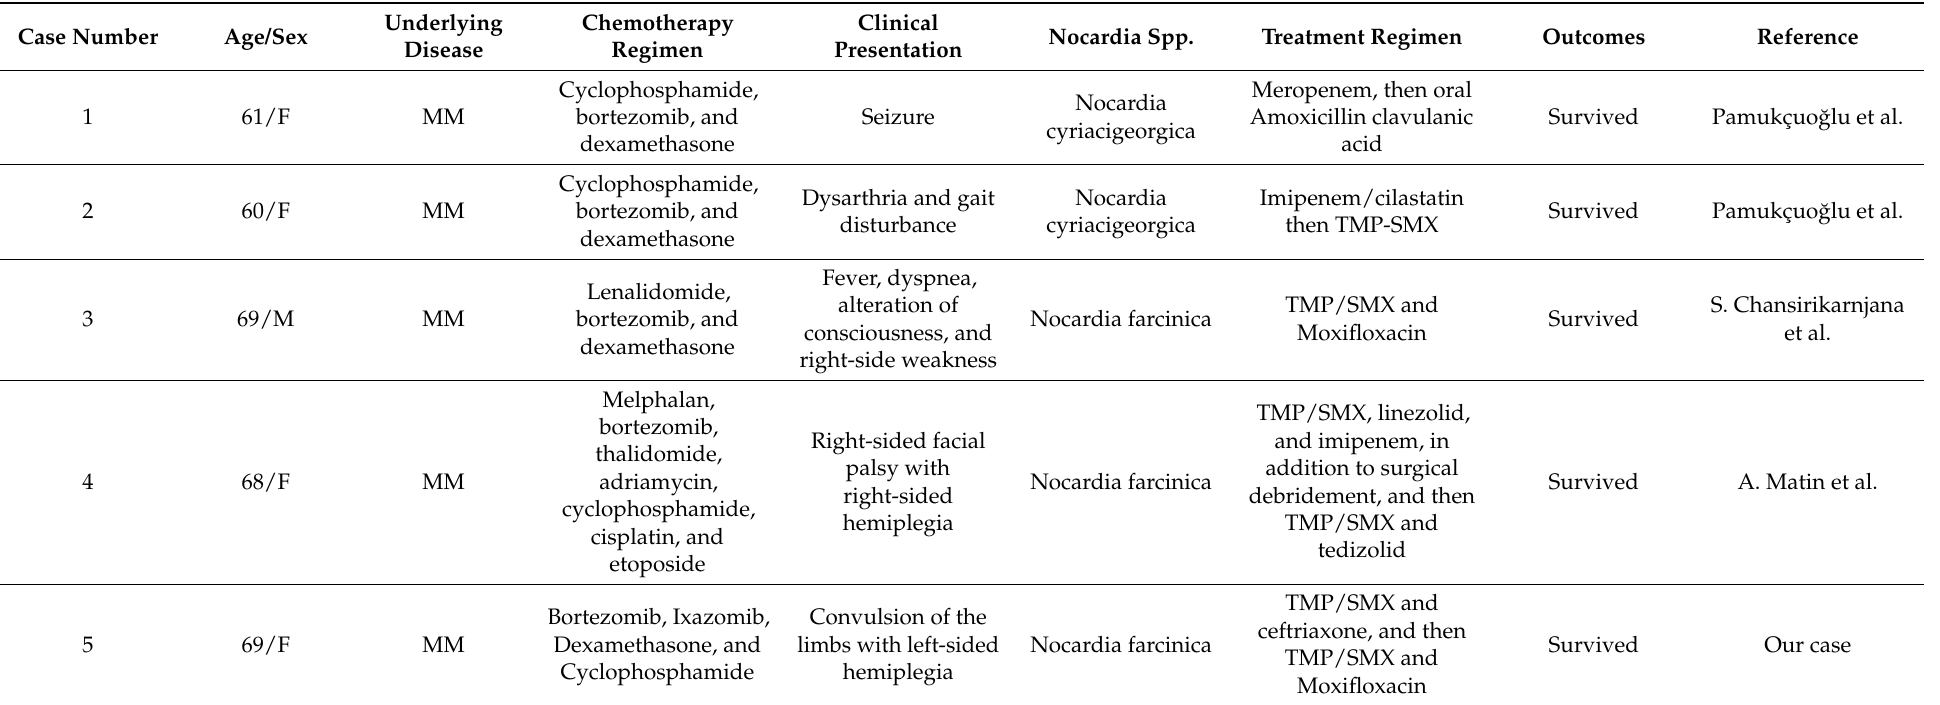
Table 2. Clinical features of previously published cases of central nervous system nocardiosis in MM